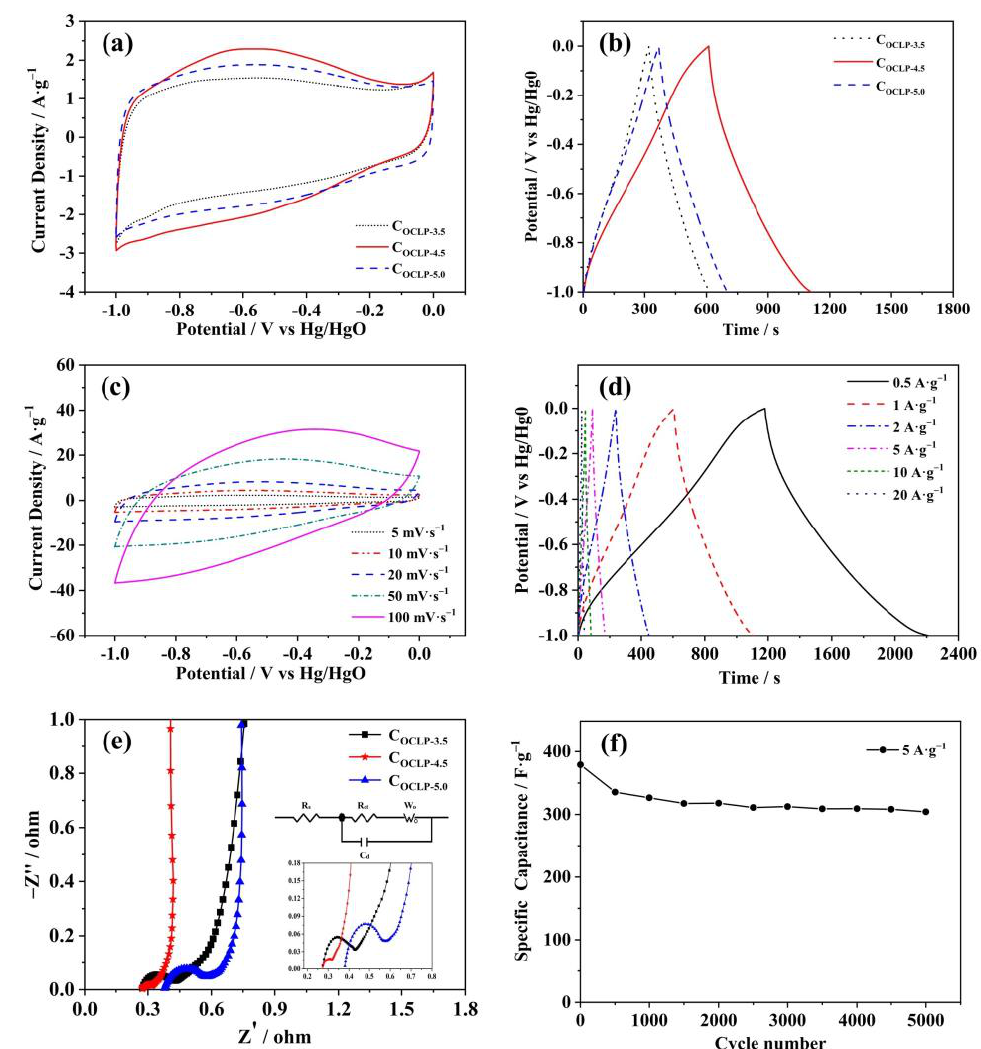
Figure 8. ( a ) CV curves of C OCLPs at a scan rate of 5 mV · s − 1 ; ( b ) GCD curves of C OCLPs at a current density of 1 A · g − 1 ; ( c ) CV curves of C OCLP-4.5 at different scan rates; ( d ) GCD curves of C OCLP-4.5 at different current densities; ( e ) Nyquist plots of the C OCLPs ; ( f ) stable cyclic performance of C OCLP-4.5 .